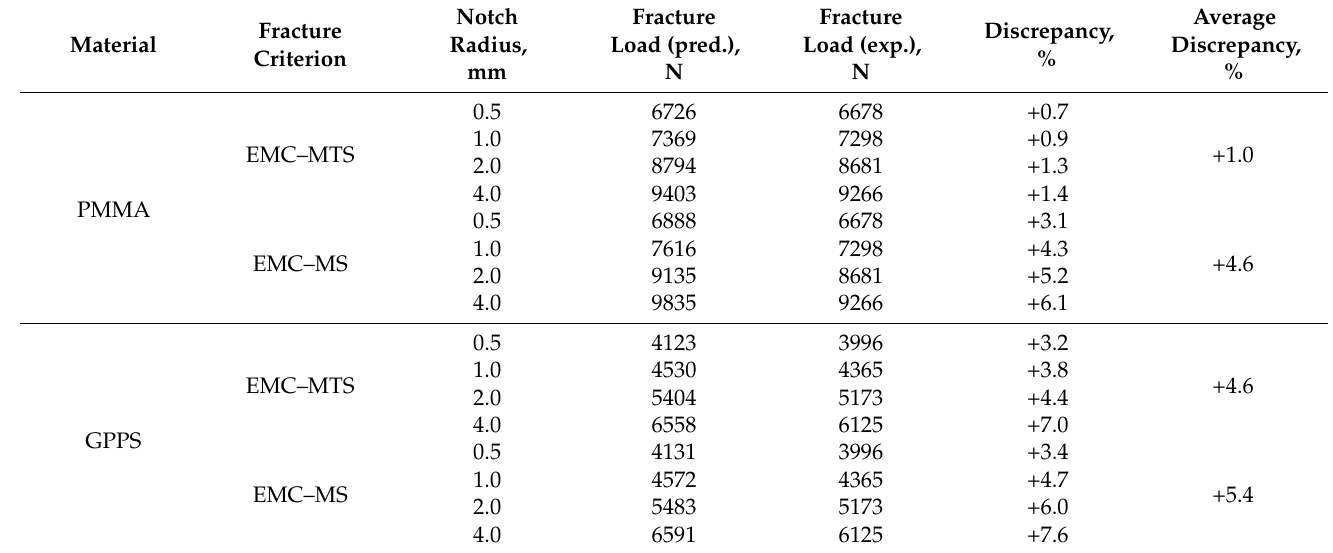
Table 5. Comparison between experimental (exp.) fracture loads and fracture prediction (pred.) derived from MTS and MS criteria (experimental calibration of critical